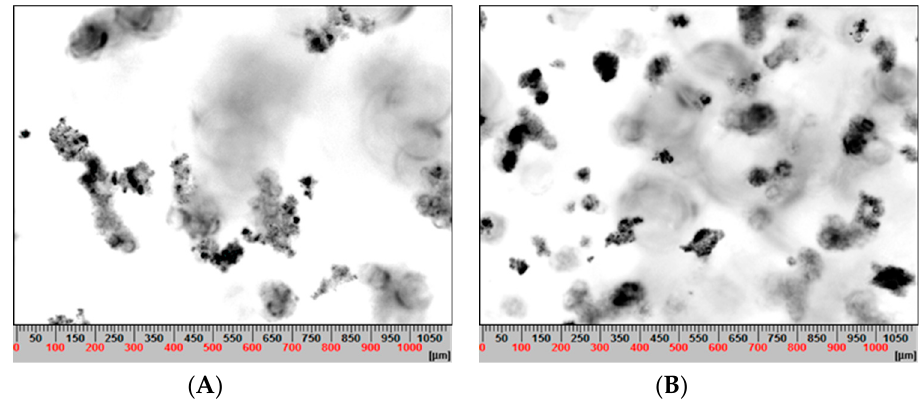
Figure 12. Suspended particles of pyrite in seawater at pH 8 interacting with flotation reagents: ( A ) 5 ppm of guar gum (7 min) and ( B ) 5 ppm of guar gum, 75 ppm of PAX, and 20 ppm of MIBC (7 min).